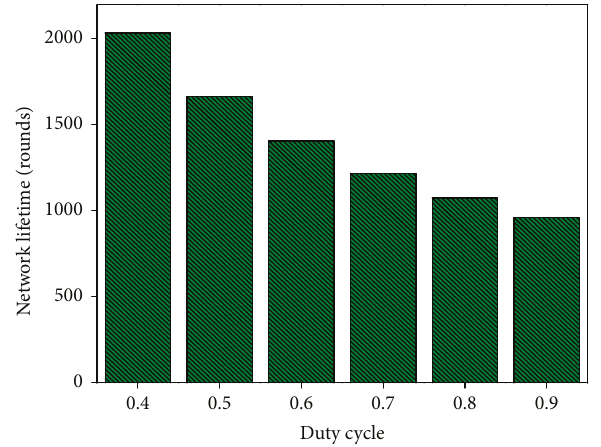
Figure 3: The network lifetime of network lifetime with di ff erent duty